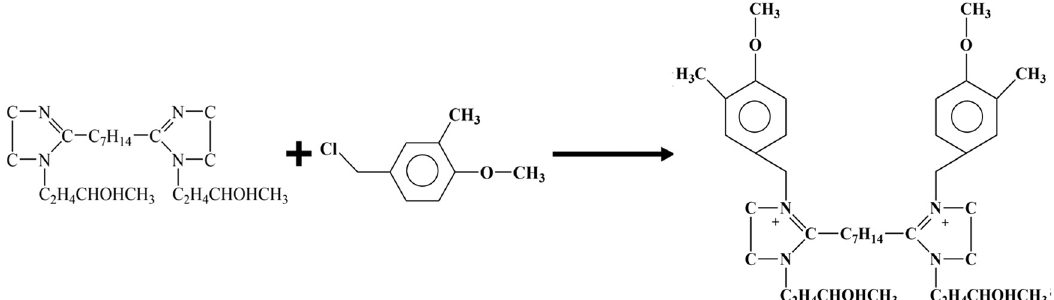
Figure 2: Quaternization reaction.